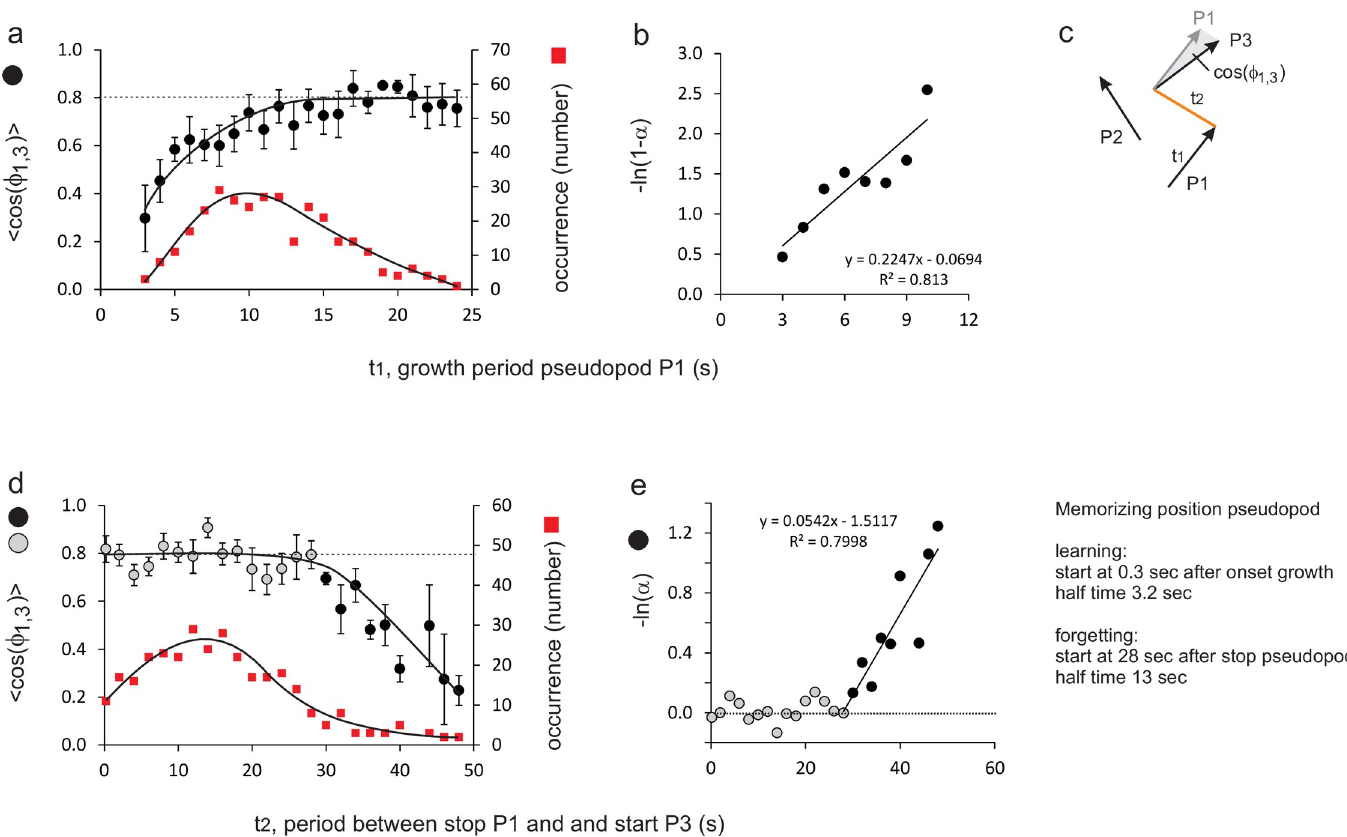
Fig 4. Kinetics of positional memory, defined by cos( ϕ 1,3). The angle between P1 and P3 was measured for different growing times of pseudopod P1 (learning time t1 in panels a, b) and for different intervals between stop of P1 and start of P3 (forgetting time t2 in panels d, e). A small angle between pseudopods P1 and P3 (i.e. cos( ϕ 1,3) close to 1.0) implies that pseudopods P1 and P3 are extended in the same direction. Panels b and e are logarithmic transformation of the data in which α = cos( ϕ 1,3) t-t0 / cos( ϕ 1,3) . The kinetic constants for learning and forgetting were obtained by linear regression analysis; the data points represented by the black bullets in panels d and max e are incorporated in the linear regression. See S1 Fig for a similar analysis using L/R bias instead of cos( ϕ 1,3).